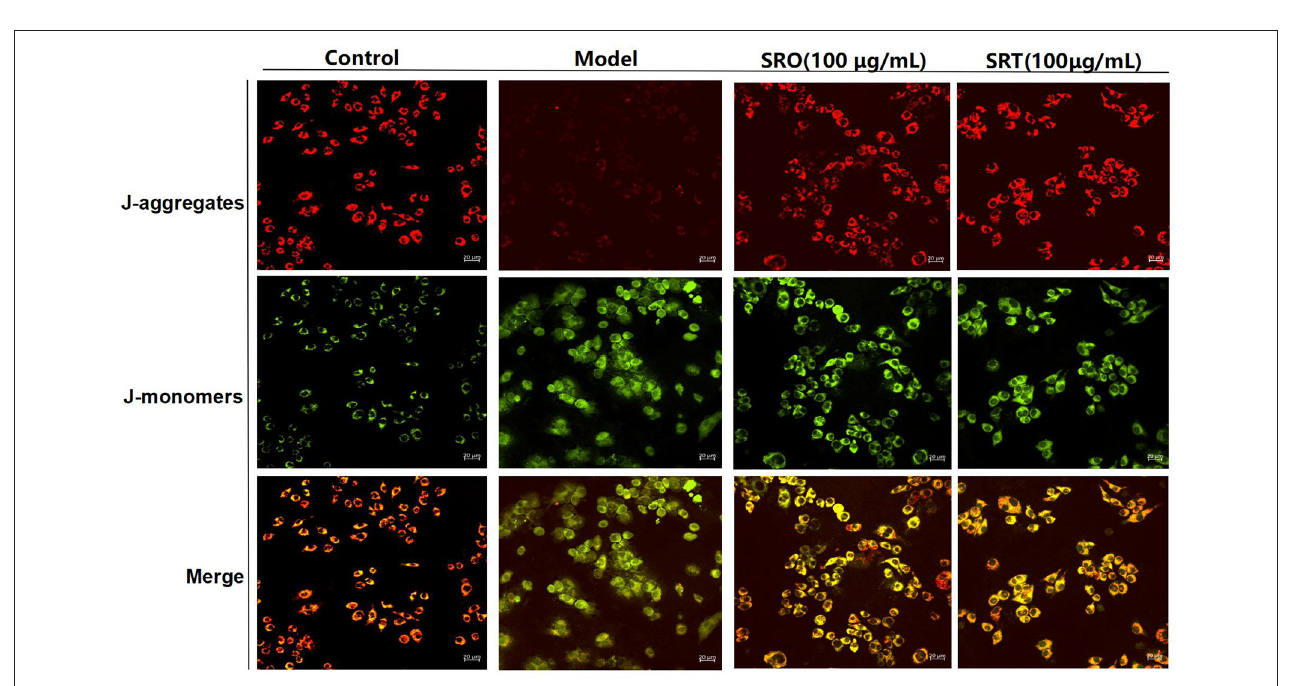
FIGURE 5 | The fluorescence for indicating the cellular MMP of RAW264.7 cells treated by SRO and SRT.